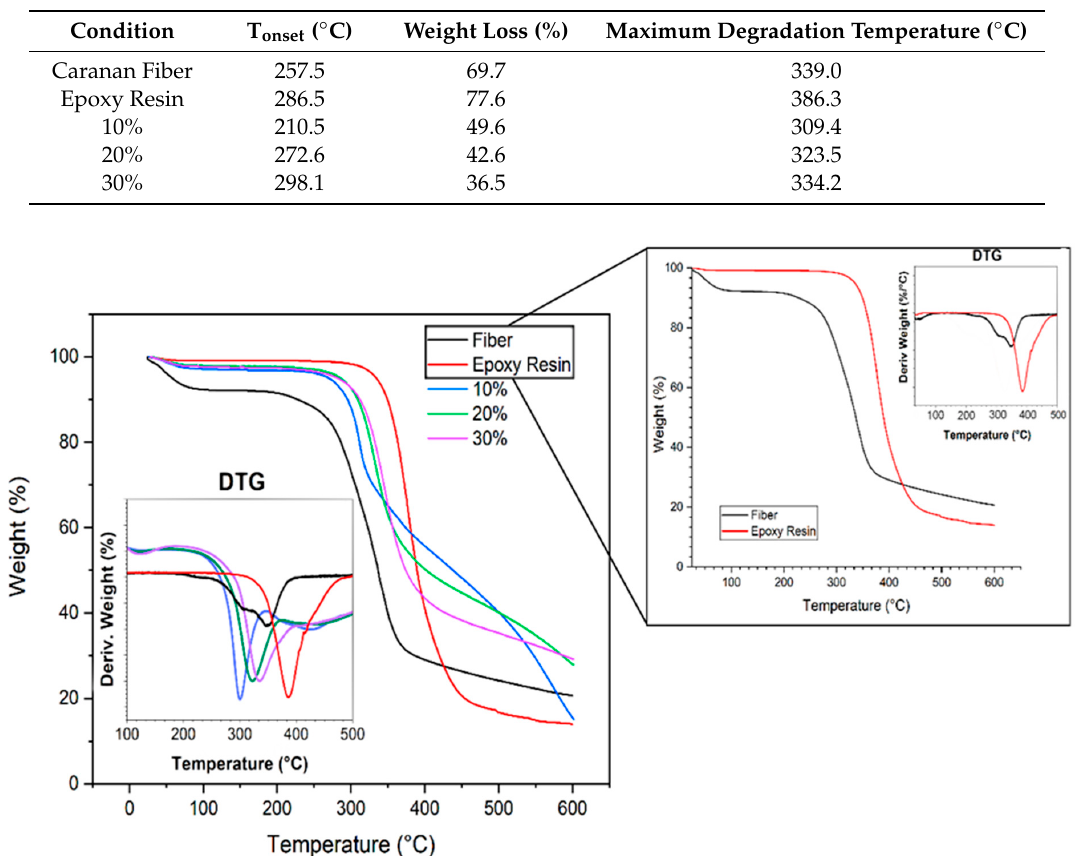
Table 4. Information about TGA analysis in di ff erent conditions.